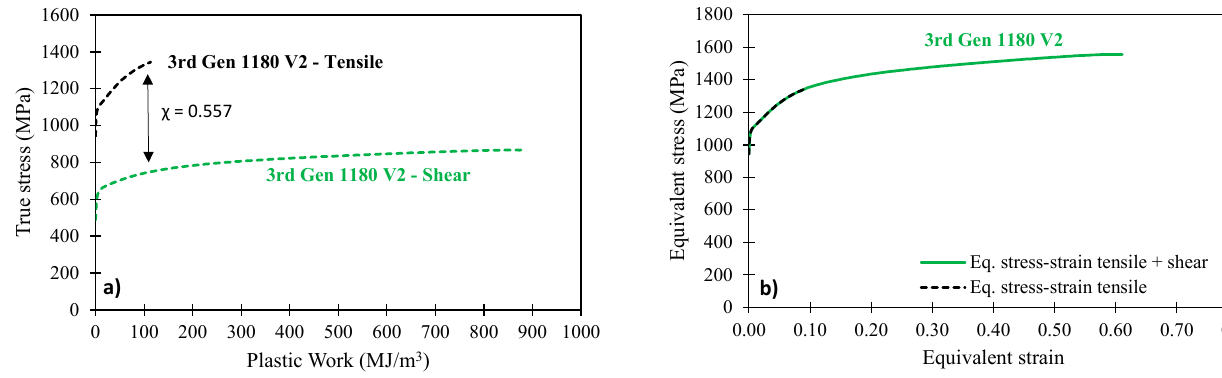
Figure 3. True stress versus plastic work ( a ) and converted equivalent stress-strain response for the 3rd Gen 1180 V2 ( b ).